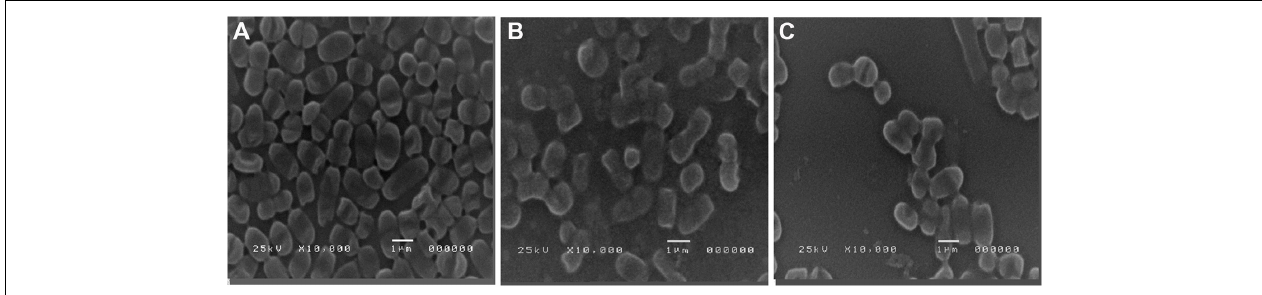
FIGURE 8 | Scanning electron microscopy images of (A) untreated strong biofilm-former A. baumannii isolate, after (B) a 24-h treatment with sub-MIC cinnamic acid, and (C) a 24-h treatment with sub-MIC gallic acid. Magnification 10,000 × .